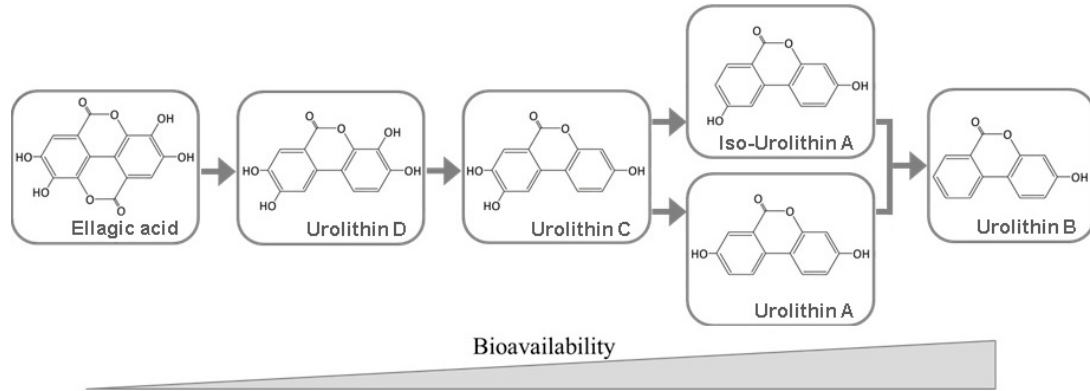
Figure 3. Urolithins derived from ellagic acid and their relative bioavailability.